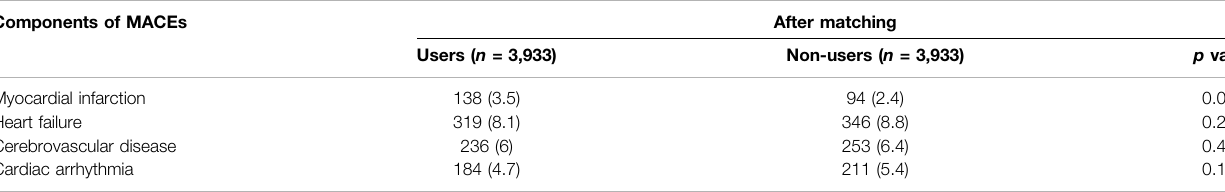
TABLE 3 | Components of MACEs between patients with dialysis comparing lipid-lowering agents users vs. non-users. Components of